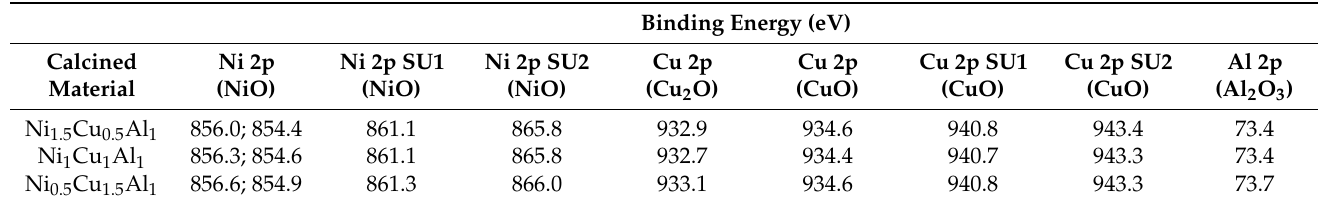
Figure 3. XPS spectra of Ni 2p, Cu 2p and O 1s of LDH precursors calcined at 673 K for 4 h. Black lines correspond to the measured spectra and the red lines are the fit. Table 3. XPS analysis of LDHs calcined at 673 K for 4 h: binding energies of the metal